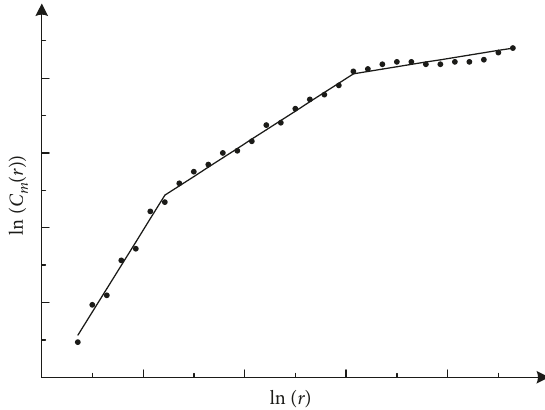
Figure 2: Geometric model of the actual system ln r ∼ ln C